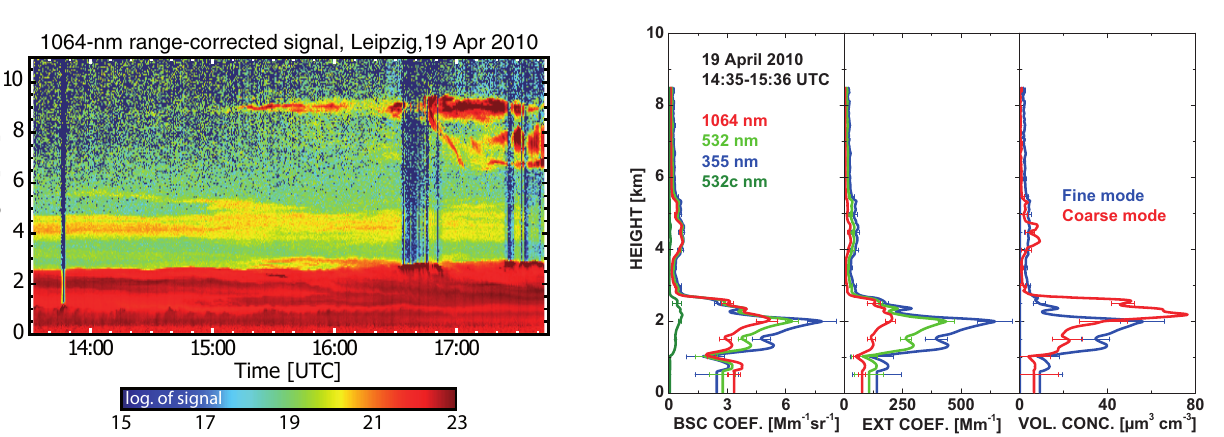
Fig. 7. Backscatter–related ˚Angstr¨om exponent (AE-BSC), extinction–related ˚Angstr¨om exponent (AE-EXT), and lidar–ratio– related ˚Angstr¨om exponent (AE-LR) observed on 29 May 2008 Fig. 8. Range–corrected signal at 1064 nm on 19 April 2010, 1332– with Raman lidar (blue circles) and derived by using the LIRIC pro- 17:43UTC. The vertical resolution is 60m; the temporal resolution 1743 UTC. The vertical resolution is 60 m, the temporal resolution files in Figure 3 (green curves). Solid green curve and closed blue is 30s. The 500nm AOT was 0.7 up to 6km height in the afternoon is 30 s. The 500 nm AOT was 0.7 up to 6 km height in the afternoon symbols show the ˚ Angstr¨om exponents for the 355–532 nm wave- of 19 April. of 19 April. length range, dashed green curve and open blue symbols for the 532–1064 nm spectral range. As outlined by Ansmann et al. (2002), AE-EXT = AE-BSC + AE-LR. Raman lidar signals are smoothed with window lengths of about 1000 m in the case of extinction co- efficients and the lidar ratio, and 60 m in the case of the backscatter coefficients. Errors bars indicate the uncertainties (one standard de- viation). LIRIC error bars are given for AE-EXT only.